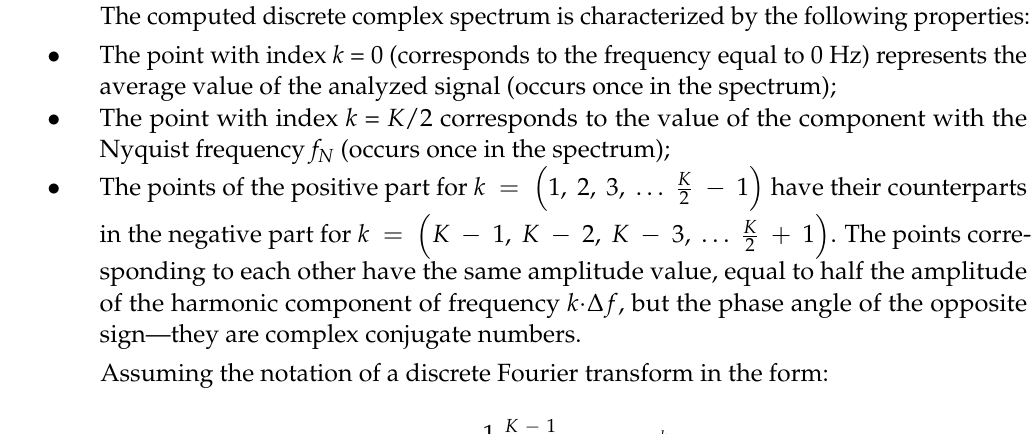
Figure 8. Module of an example complex spectrum calculated by means of the DFT (FFT) algorithm.